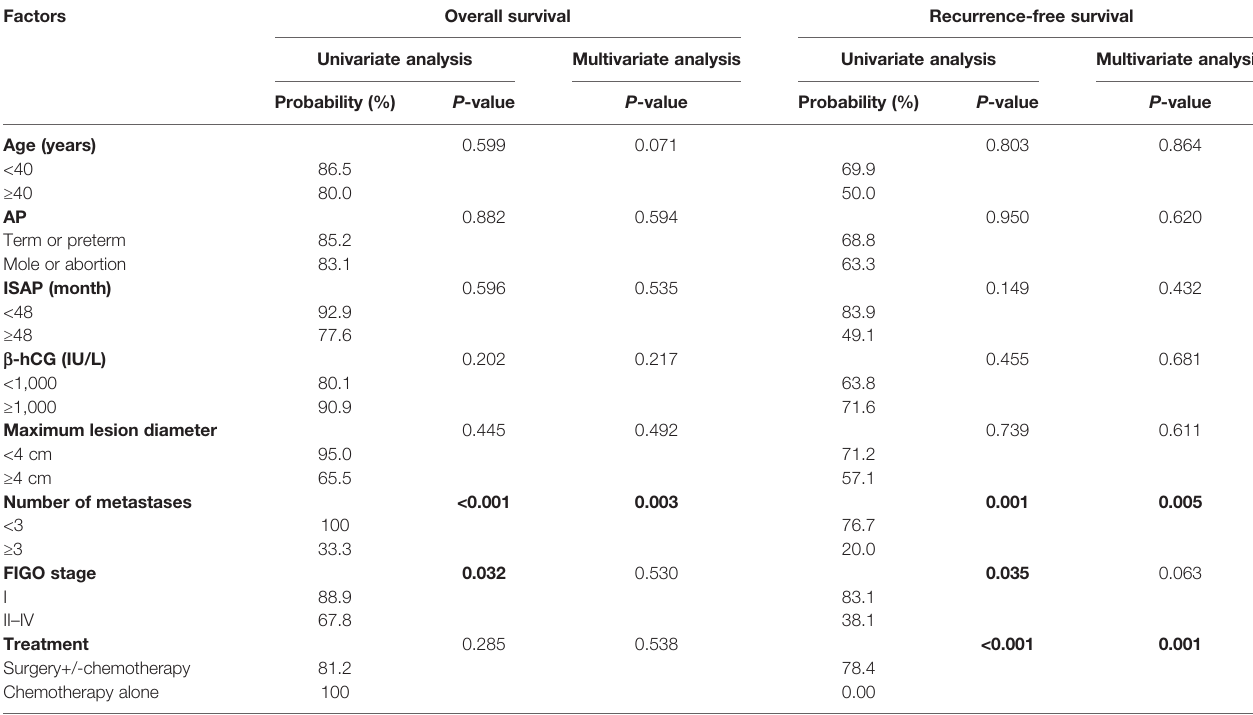
TABLE 4 | Univariate and multivariate analyses of the prognostic factors associated with 5-year overall and recurrence-free survival.